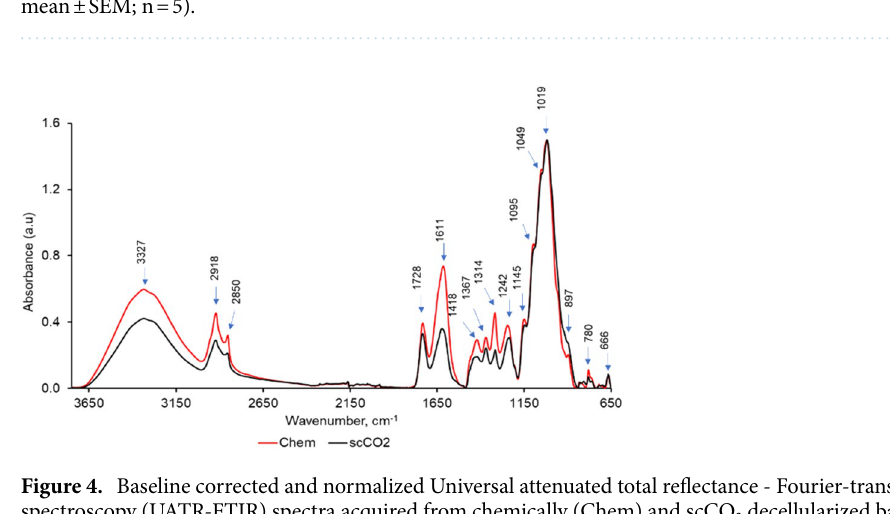
Figure 3. AFM imaging and spectrometry measurement. ( a ) Representative false colored three-dimensional surface mapping images and ( b ) Young’s modulus of scCO 2 and chemically decellularized scaffolds (data as mean ± SEM; n = 5).